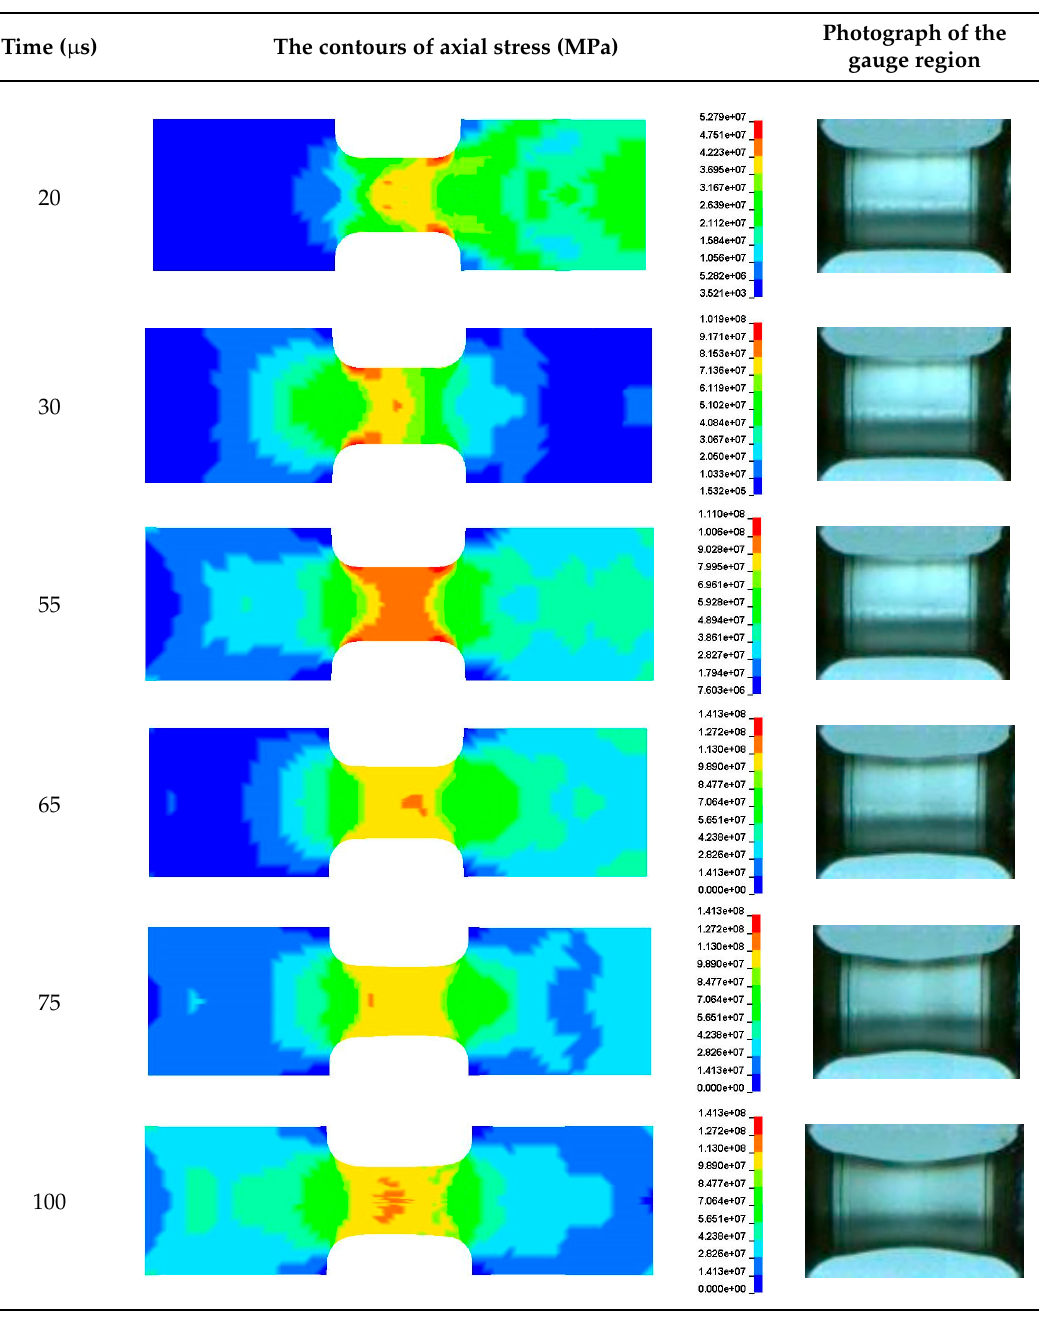
Photograph of the